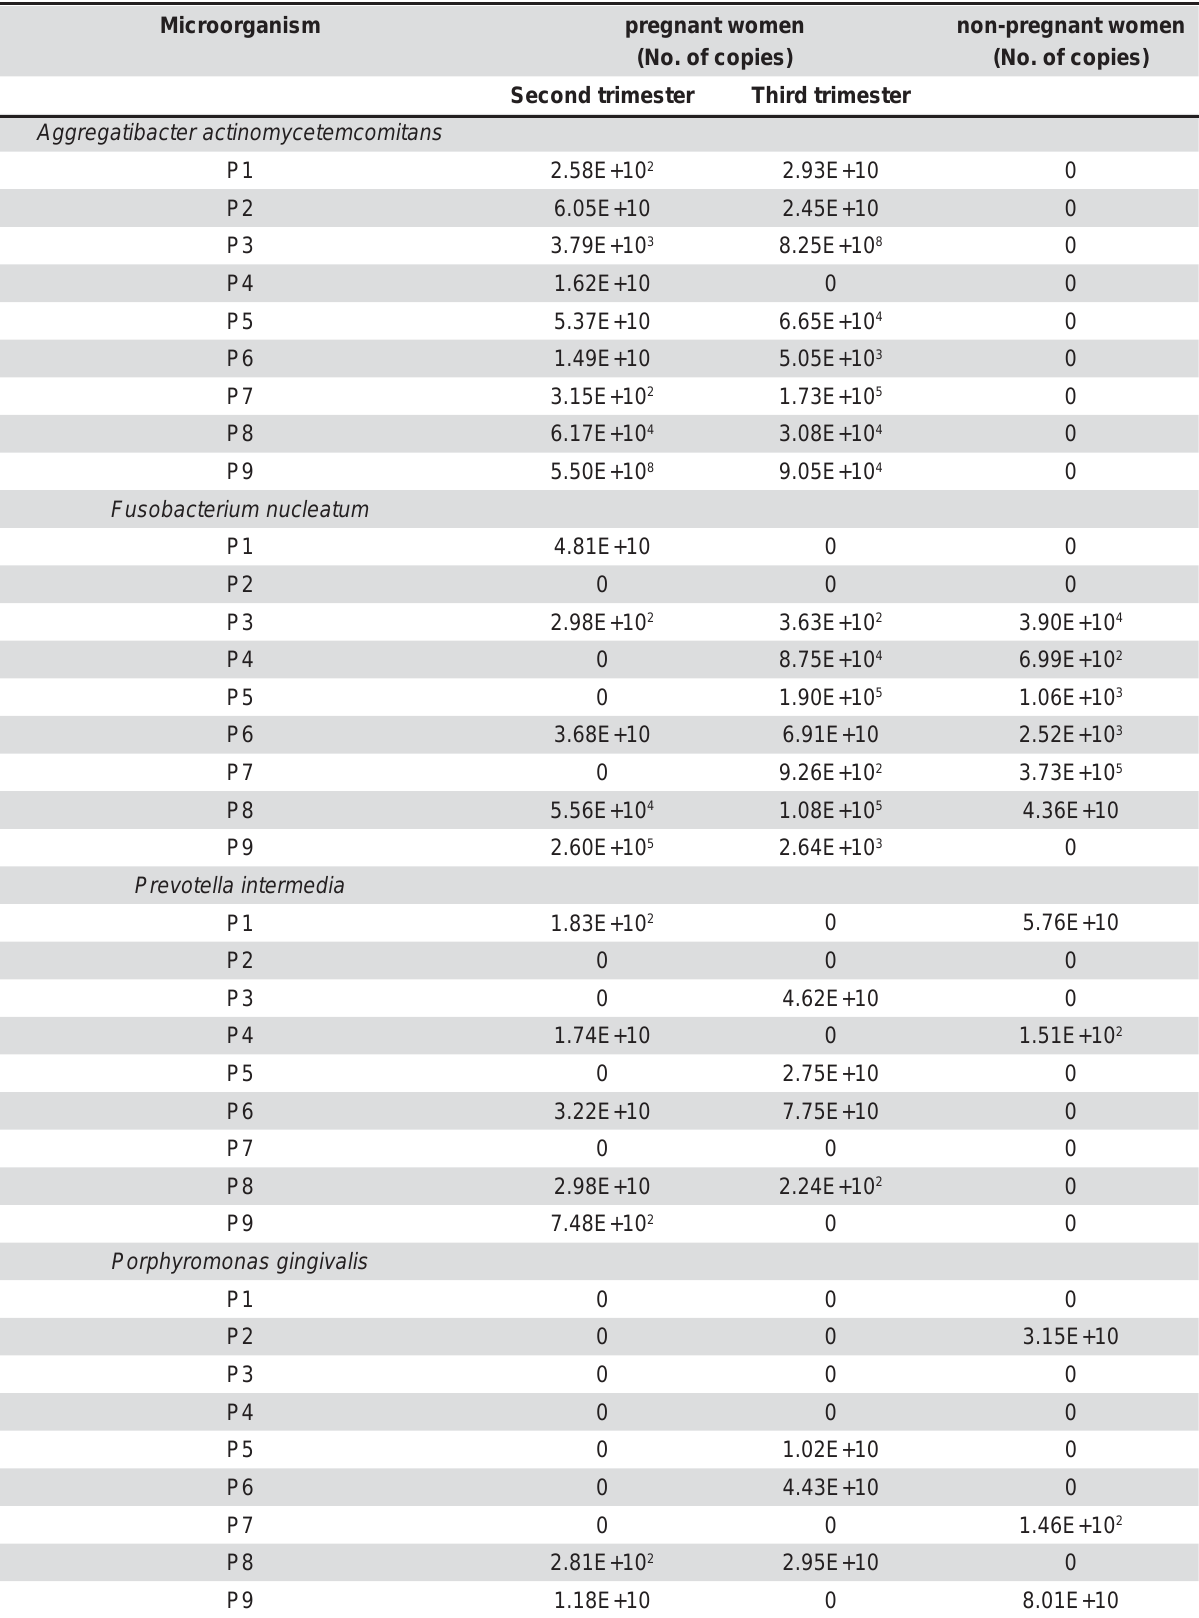
Table 2- (cid:3)(cid:52)(cid:88)(cid:68)(cid:81)(cid:87)(cid:76)(cid:87)(cid:68)(cid:87)(cid:76)(cid:89)(cid:72)(cid:3)(cid:71)(cid:72)(cid:87)(cid:72)(cid:85)(cid:80)(cid:76)(cid:81)(cid:68)(cid:87)(cid:76)(cid:82)(cid:81)(cid:3)(cid:82)(cid:73)(cid:3)(cid:73)(cid:82)(cid:88)(cid:85)(cid:3)(cid:83)(cid:72)(cid:85)(cid:76)(cid:82)(cid:71)(cid:82)(cid:81)(cid:87)(cid:68)(cid:79)(cid:3)(cid:69)(cid:68)(cid:70)(cid:87)(cid:72)(cid:85)(cid:76)(cid:68)(cid:3)(cid:76)(cid:81)(cid:3)(cid:86)(cid:88)(cid:69)(cid:74)(cid:76)(cid:81)(cid:74)(cid:76)(cid:89)(cid:68)(cid:79)(cid:3)(cid:69)(cid:76)(cid:82)(cid:191)(cid:79)(cid:80)(cid:3)(cid:73)(cid:85)(cid:82)(cid:80)(cid:3)(cid:90)(cid:82)(cid:80)(cid:72)(cid:81)(cid:3)(cid:68)(cid:87)(cid:3)(cid:87)(cid:75)(cid:72)(cid:3)(cid:21) nd and 3 rd trimester of pregnancy and non-pregnant